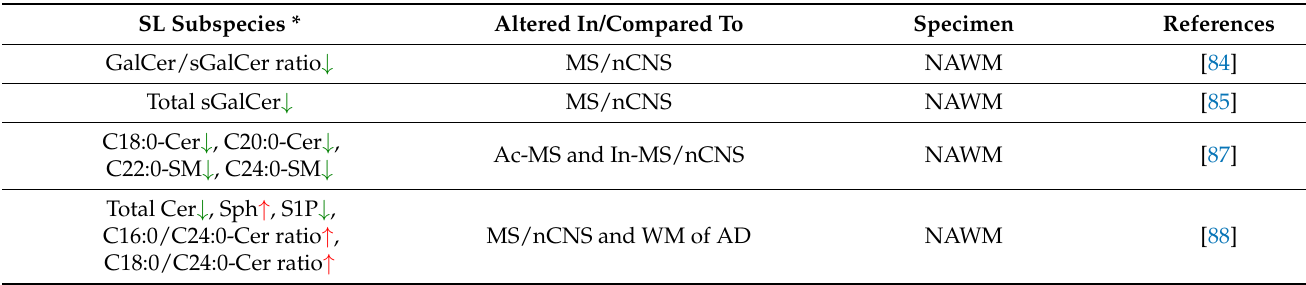
Table 2. SL alterations in